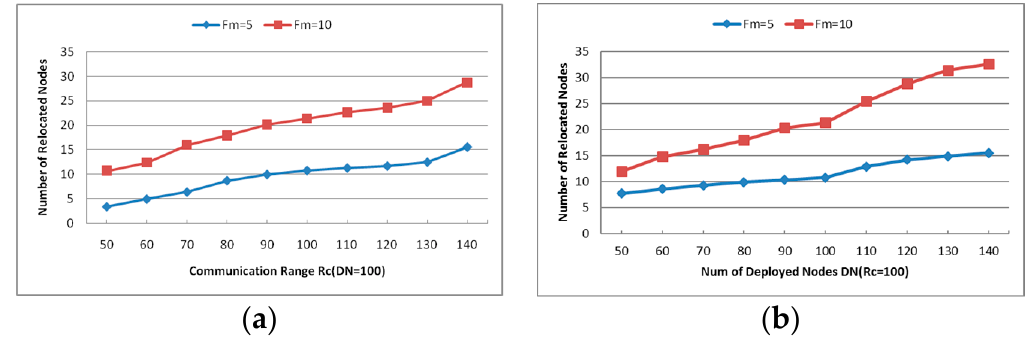
Figure 16. ( a ) RN with different R c and Fm; and ( b ) RN with different DN and Fm.